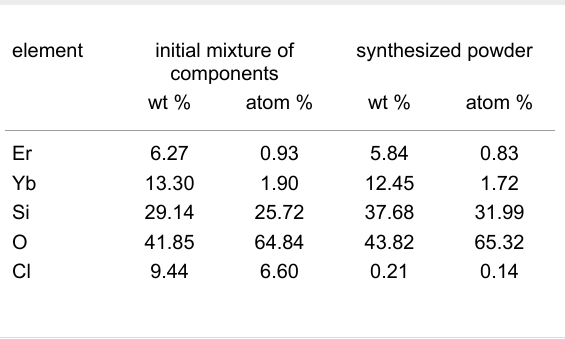
Table 1: Quantitative data of composition analyses.